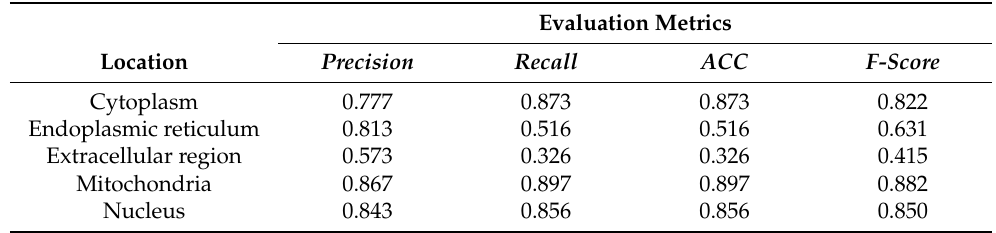
Table 1. The performance of DeepmRNALoc on the training set (in Dataset 1) using 5-fold cross-